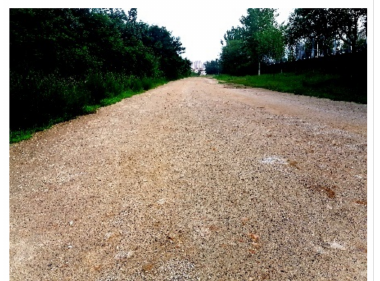
Figure 12. Gravel